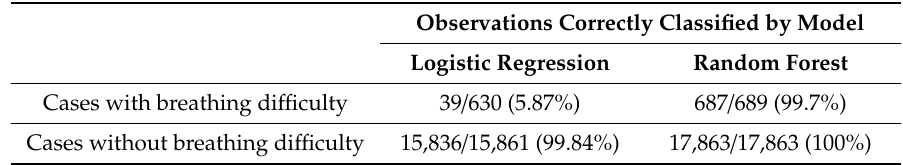
Table 4. Classification results for both regression and RF models. Note that the sample sizes are di ff erent due to how missing data are handled in RF